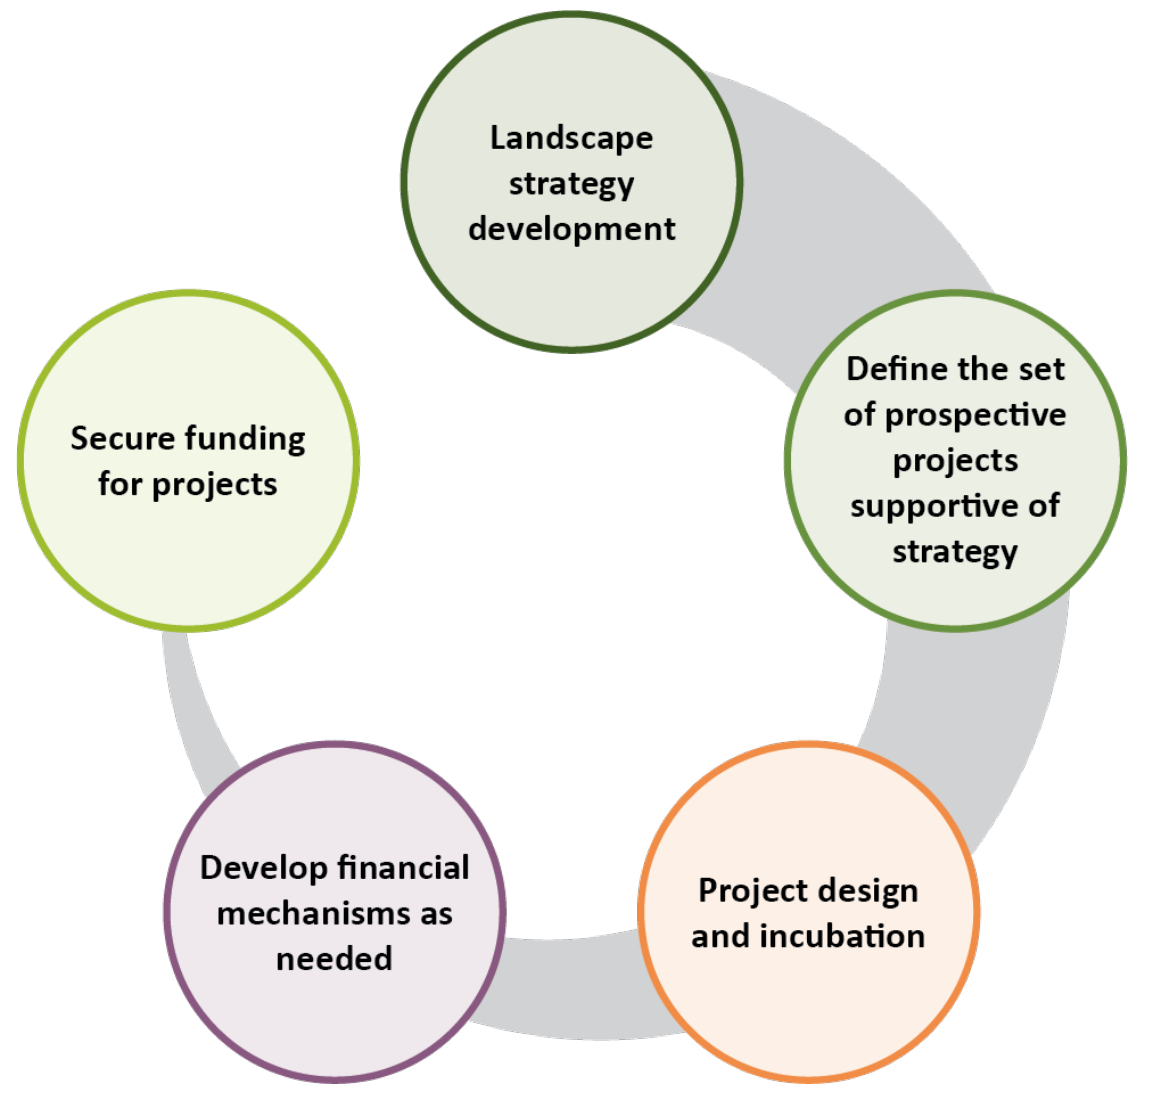
Figure 1. Framework for integrated landscape finance. Source: adapted from the 1000 Landscapes Finance Solutions Design Team [1].